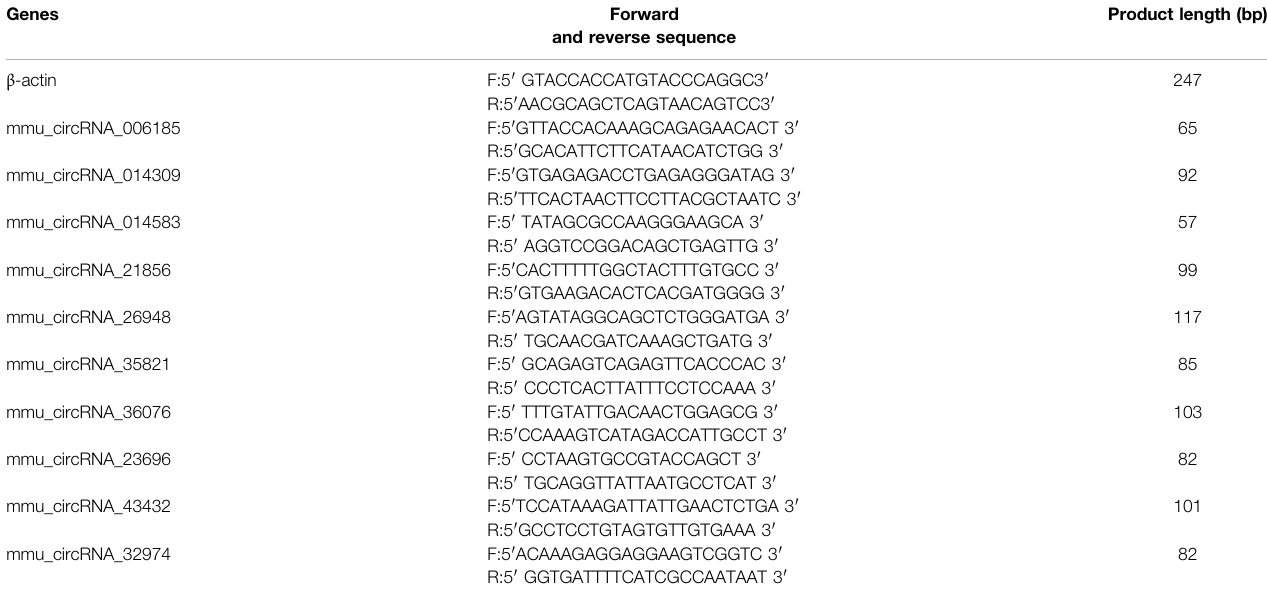
TABLE 1 | Primers used for